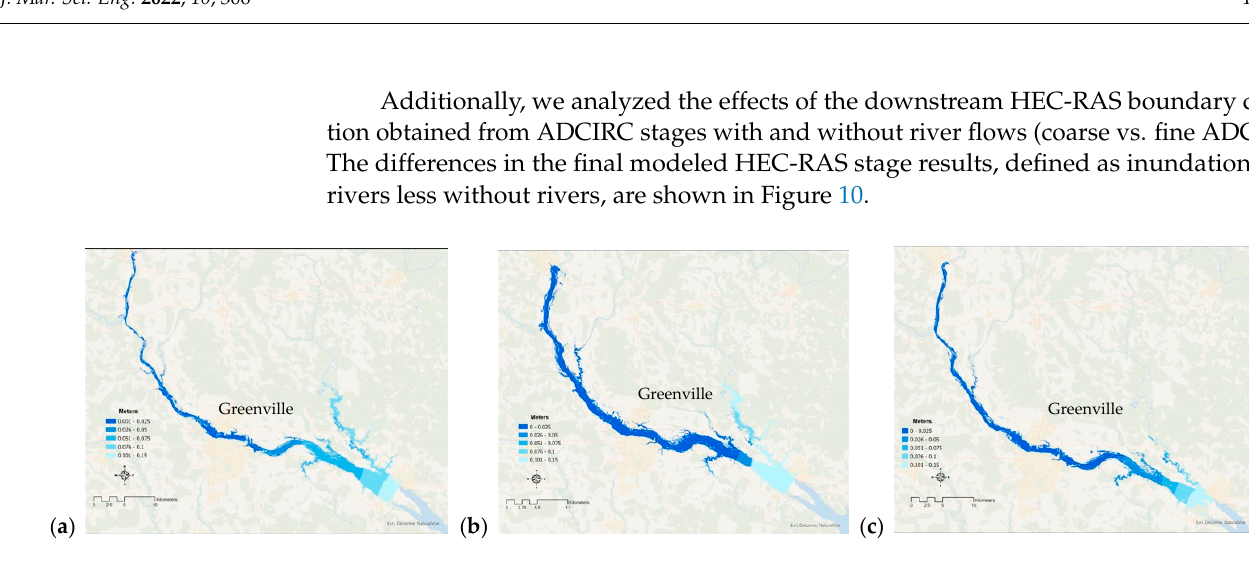
Figure 10. Differences in the HEC-RAS inundation depths between results with versus without river stages being used at the downstream boundary for ( a ) Hurricane Irene, ( b ) Hurricane Floyd, and ( c ) the April 2003 event. Note that the color scale in all the figures is the same.